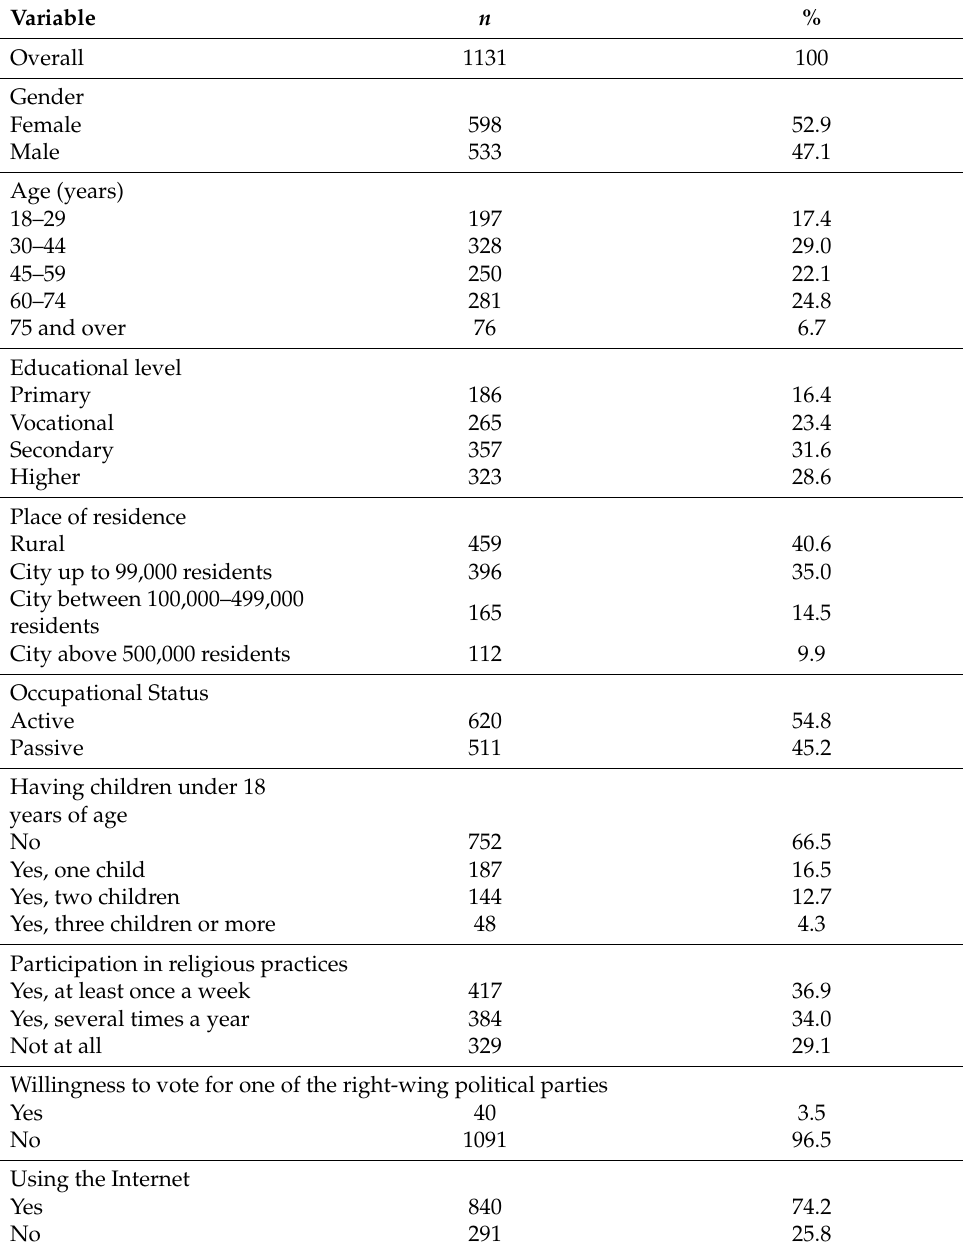
Table 1. Characteristics of the study group ( n =